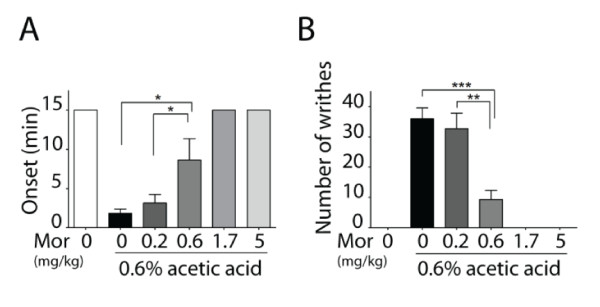
Validation of visceral pain induced with acetic acid. Visceral pain was induced with acetic acid in ICR species of mice. The onset (A) and the total number of writhes (B) during a period of 15 minutes were determined after s.c. administration of morphine (0.2, 0.6, 1.7, 5 mg/kg) 20 minutes before i.p. injection of 0.6% acetic acid. Intraperitoneal injection of 0.6% AA resulted in a significant reduction in onset time of writhes and increased number of writhes. Morphine significantly increased the onset and decreased the total number of writhes at a dose of 0.6-5 mg/kg (mean ± s.e.m., n = 6-10, *p < 0.05, **p < 0.01, ***p < 0.001).